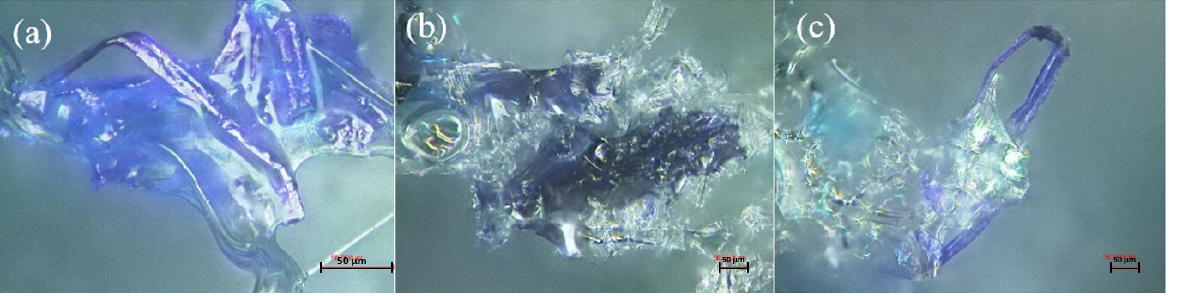
Figure 9. Microscopic observation of treated wood fibers in polyurethane matrix: ( a , b ) fiber adhe- sion, ( c ) non-reacted fiber.